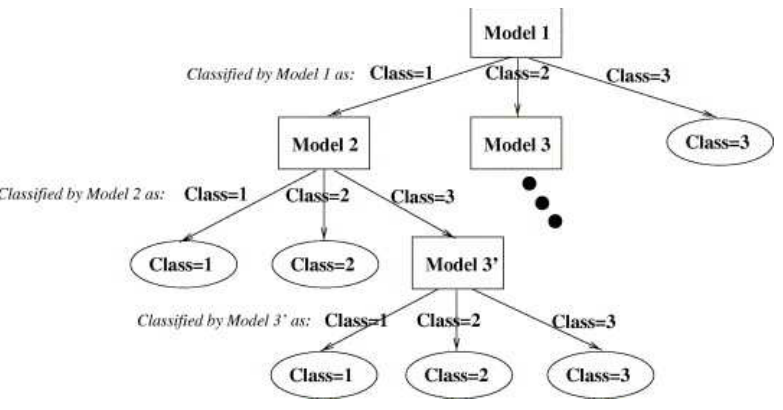
Figure 7. Hierarchical classifier